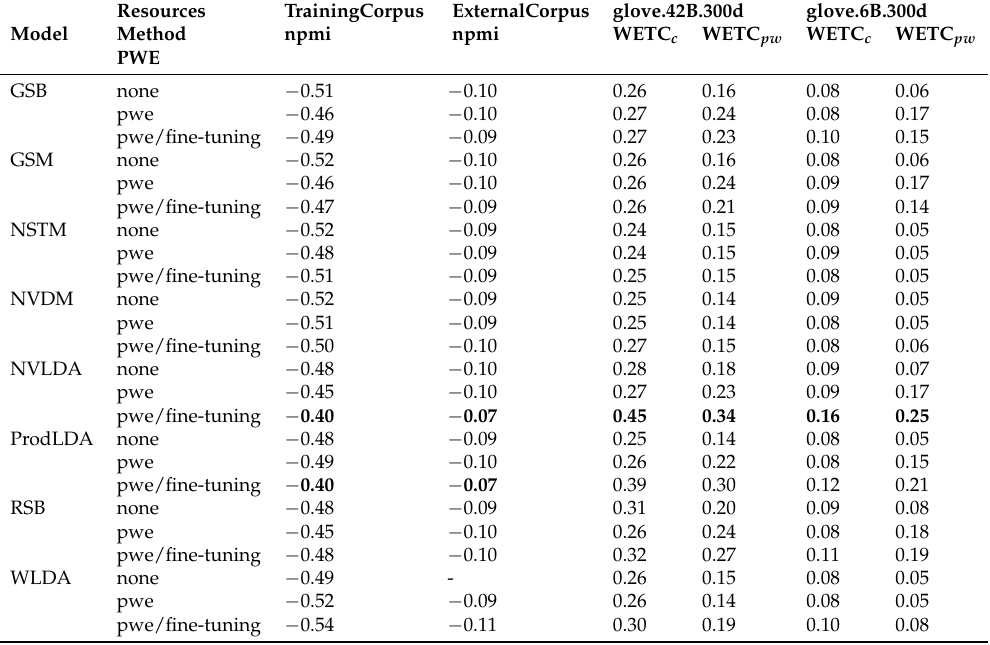
Table 9. Topic Coherence on